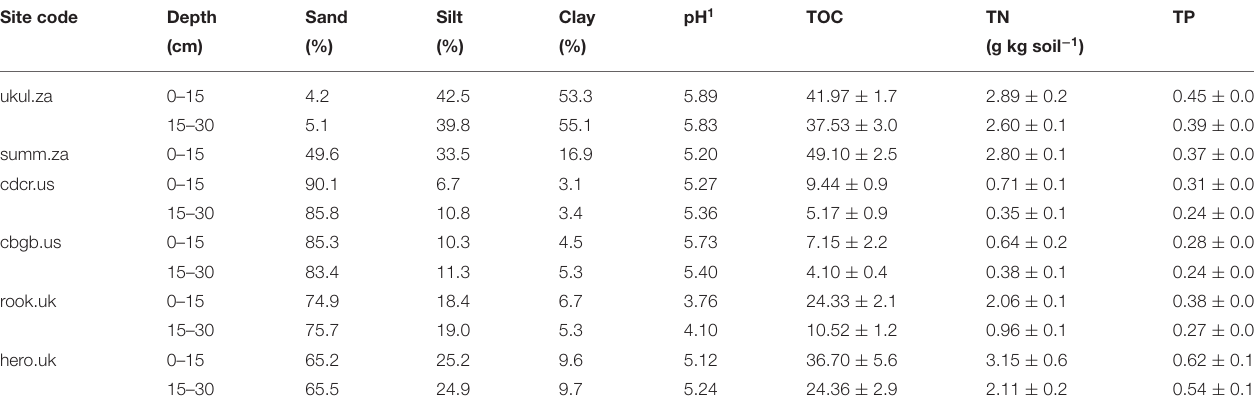
TABLE 2 | Soil texture, pH, total organic carbon (TOC), total nitrogen (TN), and total phosphorus (TP) in 0–15cm and 15–30cm depth in the soils of the control treatment at the six sites. Site